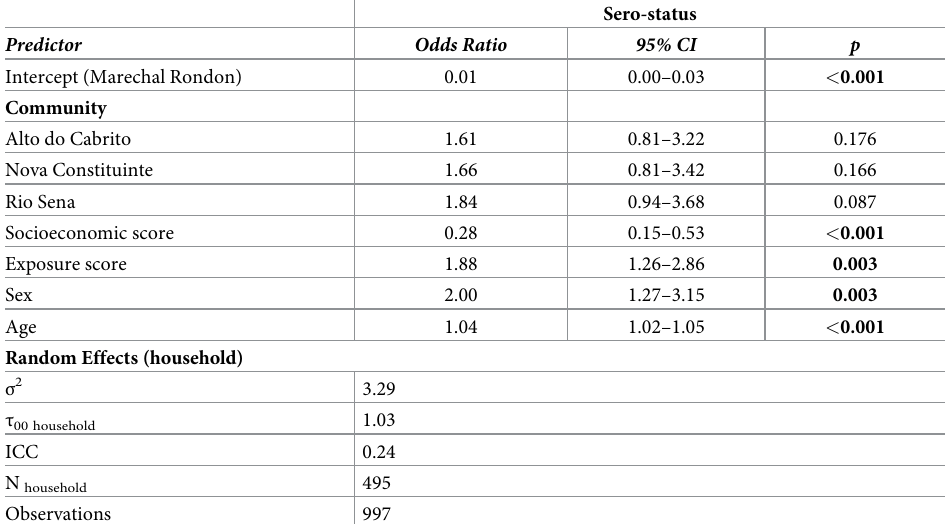
Table 2. Summary of generalized linear mixed effects model with sero-status of residents as binary response vari- able. The predictor variables were those maintained in the final structural equation model, but also controls for com- munity and household (random effect)